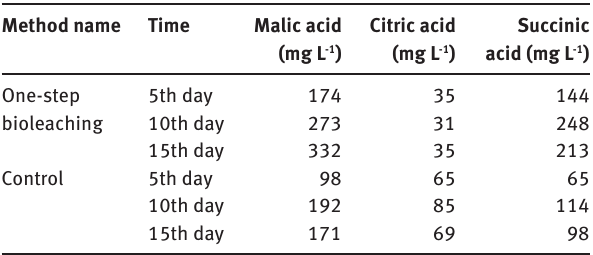
Figure 3: Changes of pH values in the one-step bioleaching process. pH levels are measured for 2 weeks for control and sample